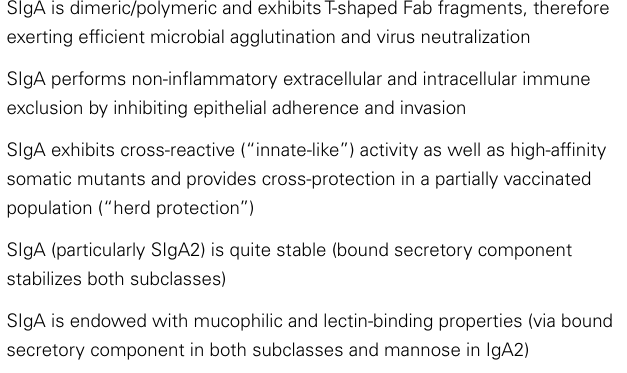
Table 2 |Anti-microbial effects of secretory IgA